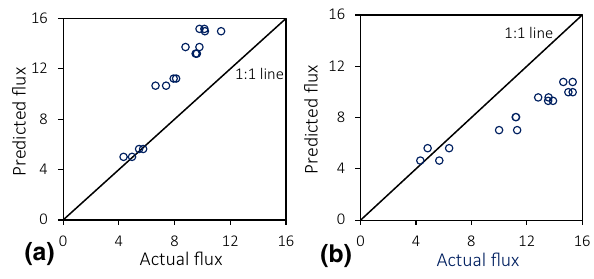
Fig. 8 Predicted water flux (L/m 2 ·h) using a Eq. (3) for the experi- ments with MgCl 2 DS and b Eq. (4) for the experiments with NaCl